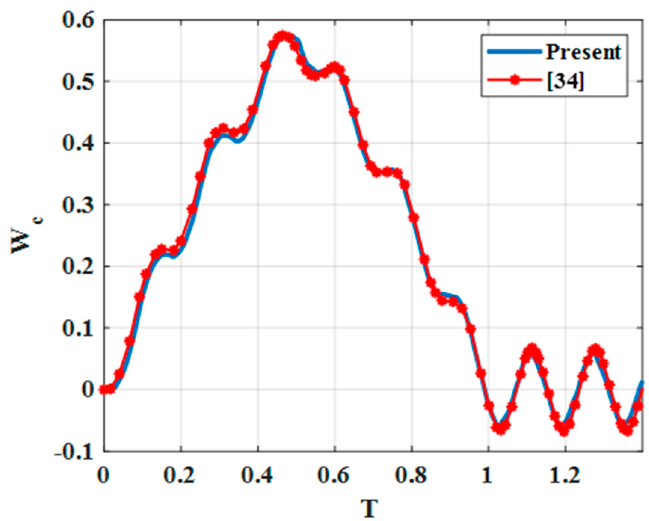
Figure 2. Non-dimensional center deflection of the plate under a moving concentrated load.